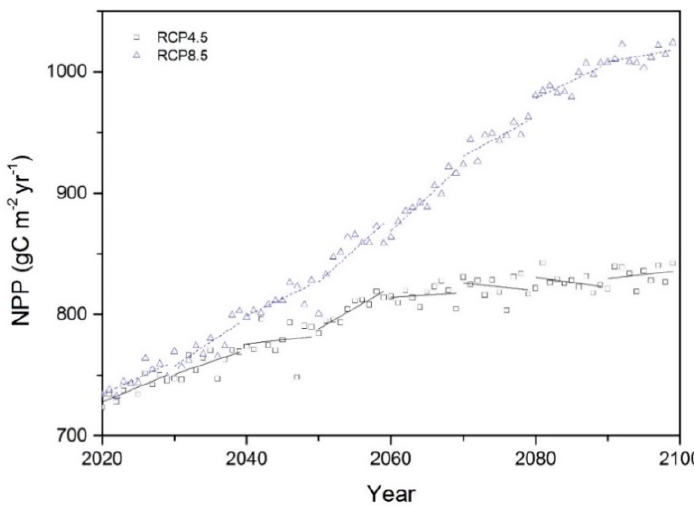
Figure 5. The annual mean NPP under the RCP4.5 and RCP8.5 scenarios during 2020 − 2099 in the YREB.